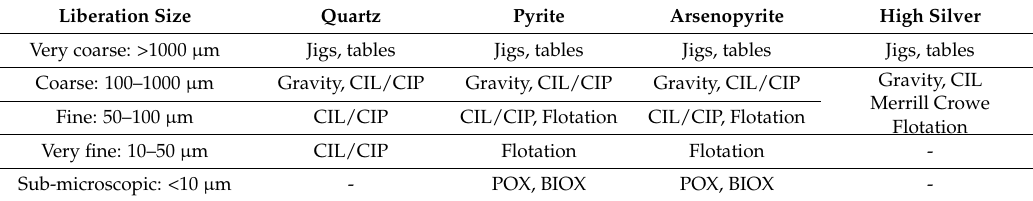
Table 2. General recovery methods based on gold liberation size and host